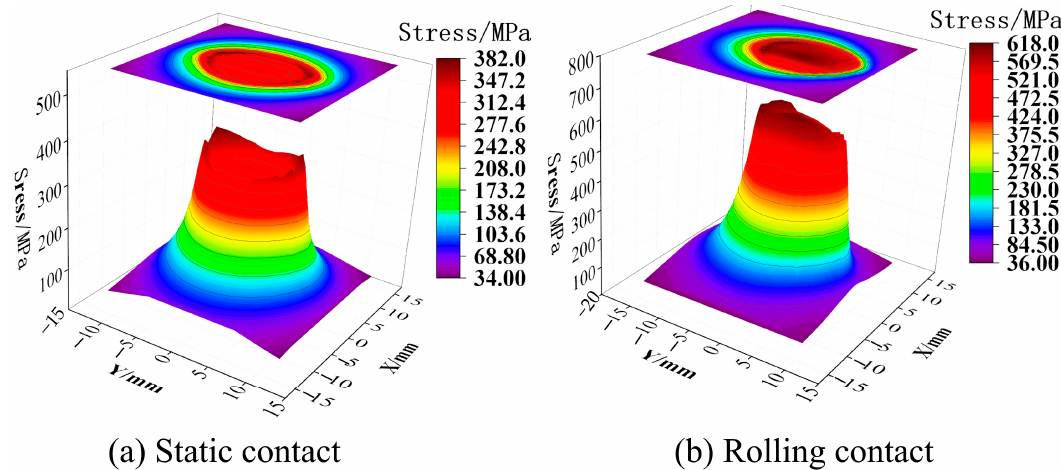
Figure 4. Rail surface stress distribution.